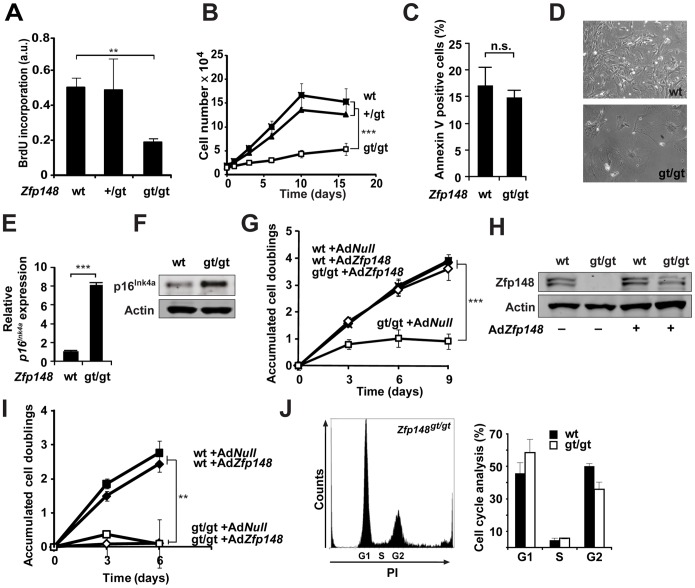
Proliferation arrest in Zfp148gt/gt MEFs.(A) Quantification of BrdU incorporation in wt, Zfp148+/gt and Zfp148gt/gt MEFs (n = 3). (B) Proliferation of Zfp148gt/gt, Zfp148+/gt, and wt MEFs (n = 4). (C) Apoptosis defined by FACS analyses of Annexin V in wt and Zfp148
gt/gt MEFs at passage 2 (n = 3). (D) Photomicrographs of wt and Zfp148gt/gt MEFs at passage 2. (E) Real-time RT-PCR of p16ink4a mRNA in wt and Zfp148gt/gt MEFs (n = 4). (F) Western blot analysis of p16ink4a protein in wt and Zfp148gt/gt MEFs. (G) Cumulative population doublings (CPD) of Zfp148gt/gt and wt MEFs transduced with AdZfp148 or AdNull at passage 0 (n = 3). (H) Western blot analysis of Zfp148 expression levels in wt and Zfp148gt/gt MEF cell lines transduced with AdZfp148. (I) CPD of Zfp148gt/gt and wt MEFs transduced with AdZfp148 or AdNull at passage 2 (n = 3). (J) Cell cycle profile of Zfp148
gt/gt MEF (left) and quantification of cell cycle distribution of Zfp148
gt/gt and wt MEFs (n = 5) (right) at passage 4 measured by FACS analysis of propidium iodide (PI)–labelled cells. **P<0.01, ***P<0.001.